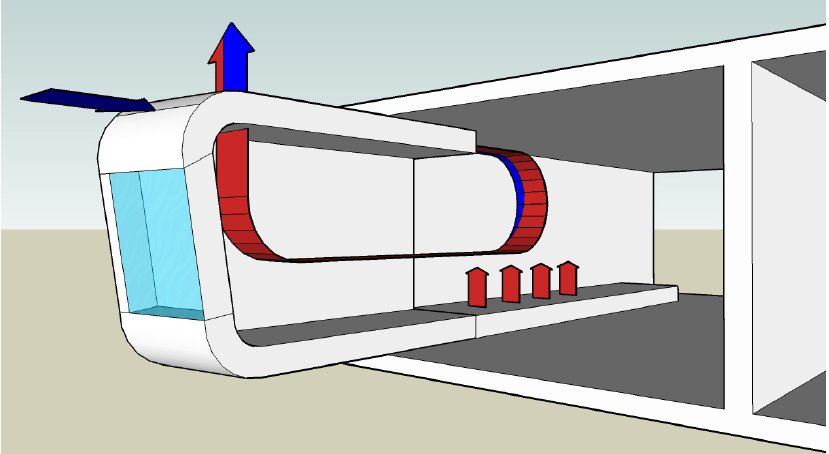
Figure 2: Sketch up of the drawer façade element.